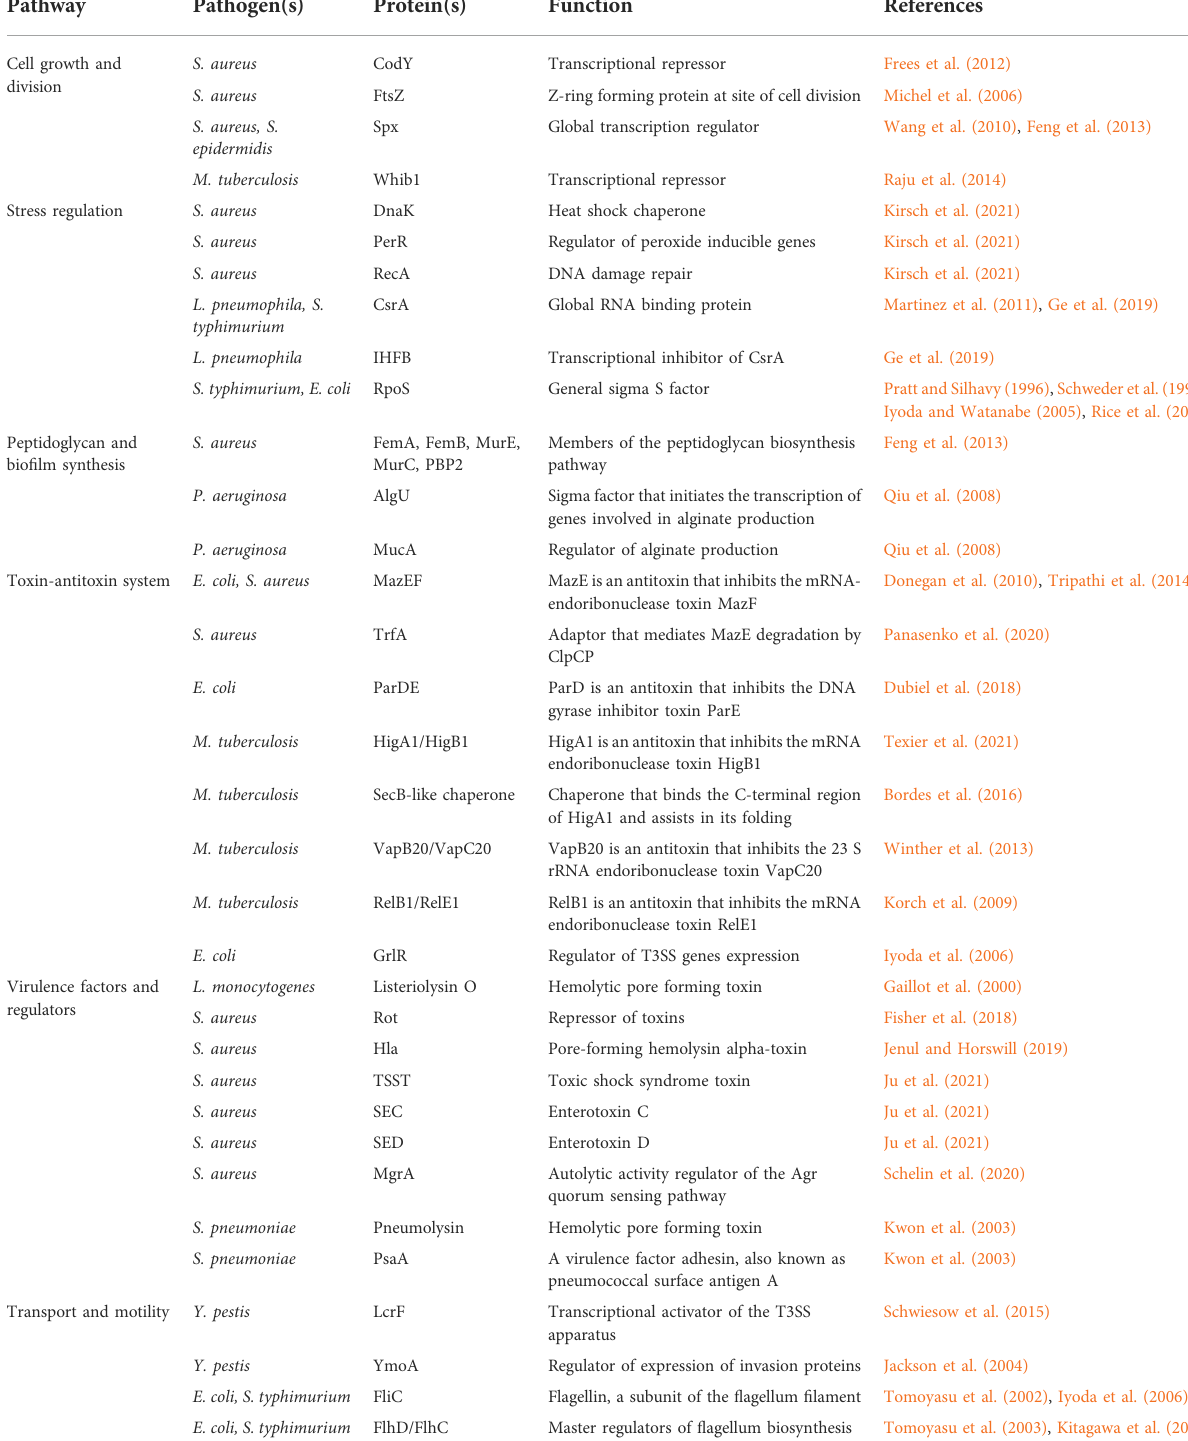
TABLE 1 Bacterial proteins and virulence factors regulated by the ClpP system discussed in this